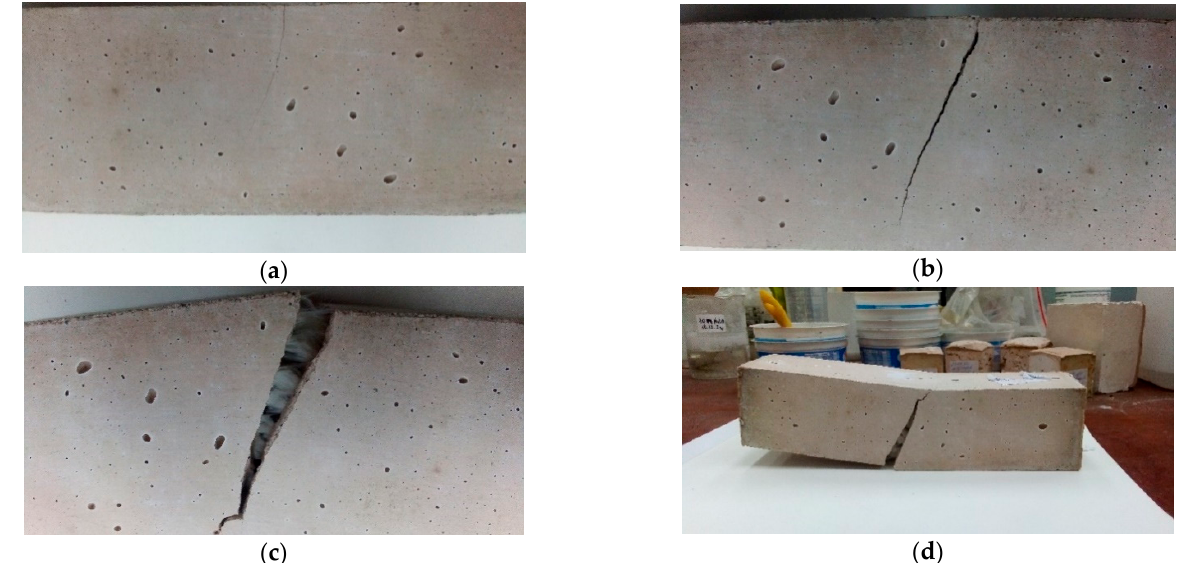
Figure 13. Crack propagation in a geopolymer composite based on metakaolin reinforced with 2.0% glass fiber roving: ( a ) first crack; ( b ) crack after second series of testing; ( c , d ) final damage of the sample.